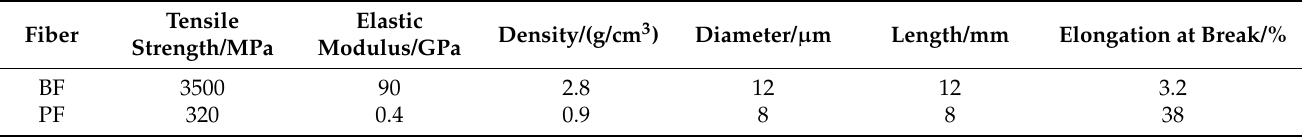
Table 1. Main performance parameters of basalt fiber and polypropylene fiber.